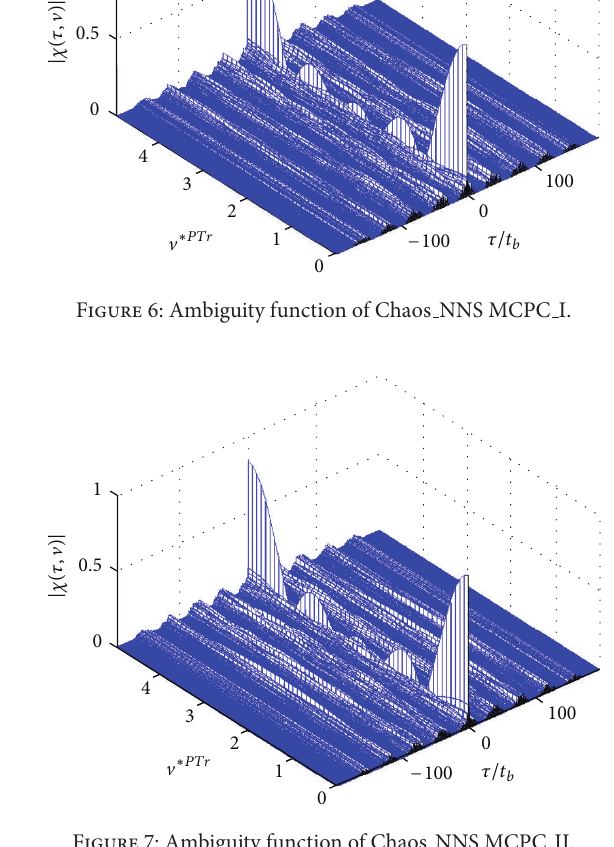
Figure 7: Ambiguity function of Chaos NNS MCPC